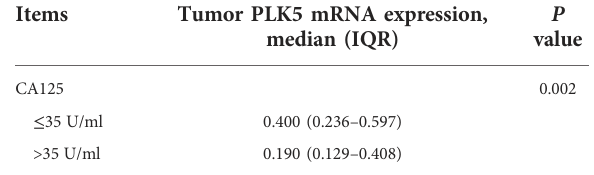
TABLE 5 Correlation of tumor PLK5 mRNA expression with clinical characteristics.